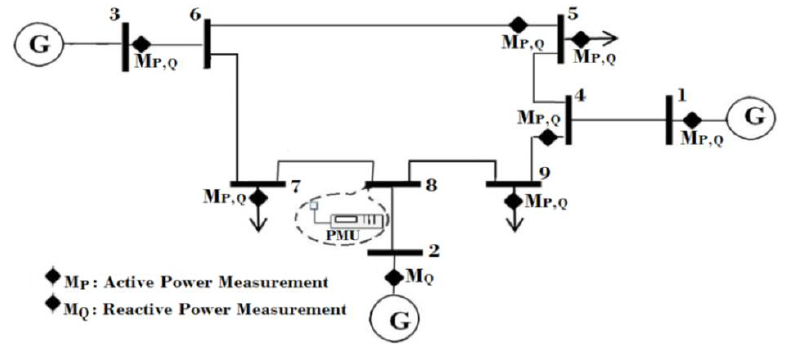
Figure 7. Single line diagram of IEEE-9 bus test system. Table 1. PCs of under study system